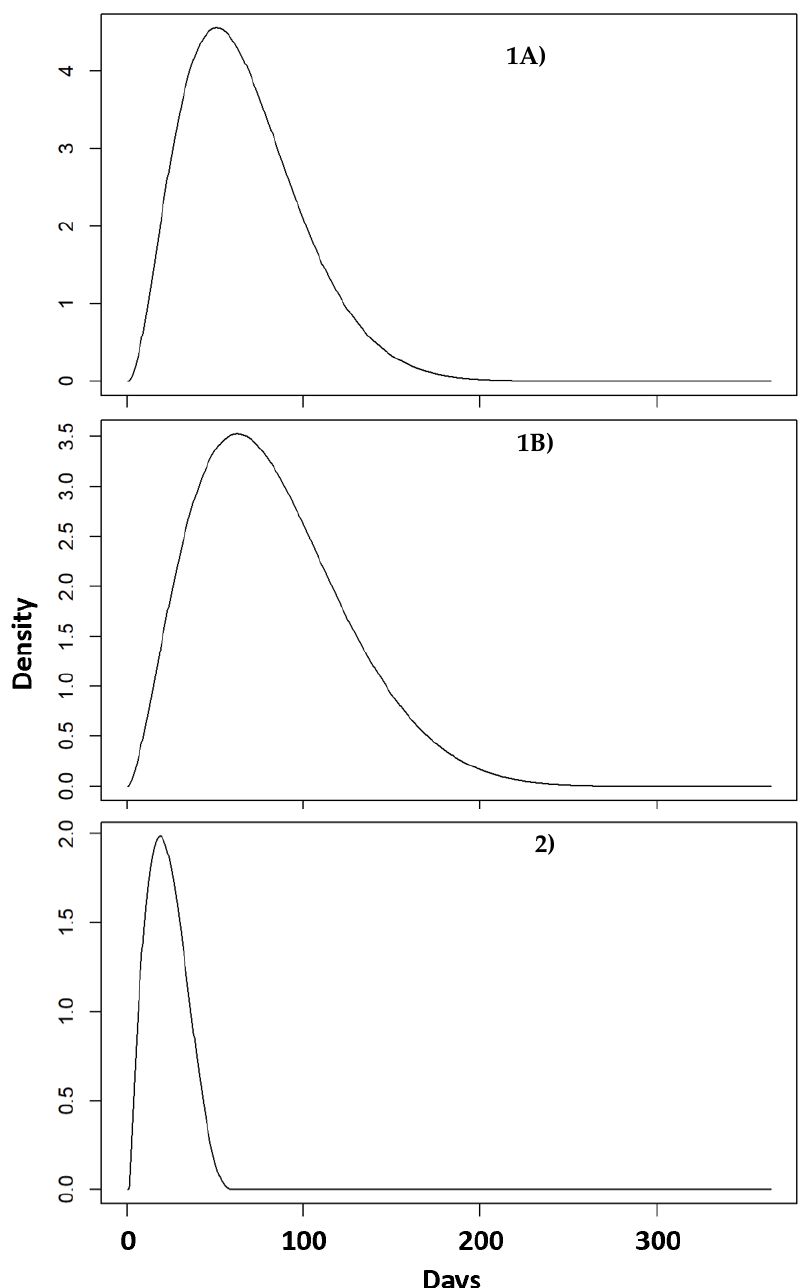
Figure 1. Elicited probability distributions for scenarios 1A (extended low salinity event in “poor” environment, 1B (extended low salinity event in “good” environment) and 2 (acute salinity change) showing the length in days of exposure resulting in death of the average bottlenose dolphin.